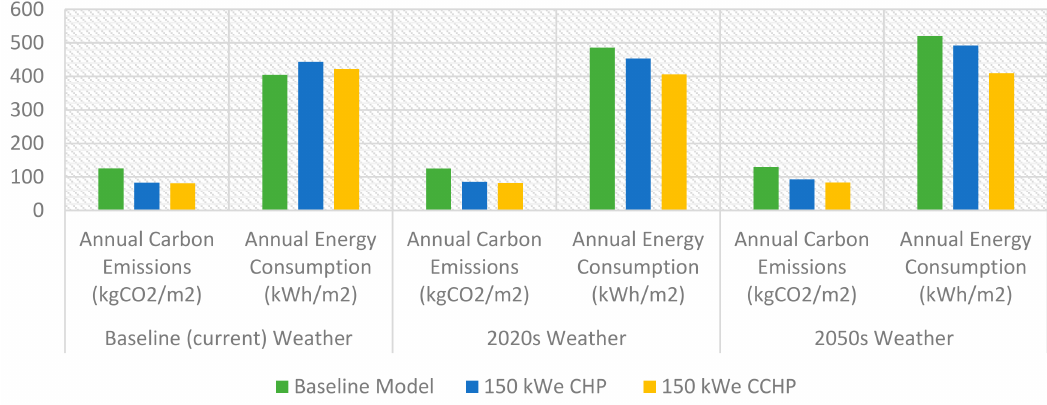
Figure 6. Comparison of building performance for baseline and future climatic scenarios without C/CHP against with CHP and